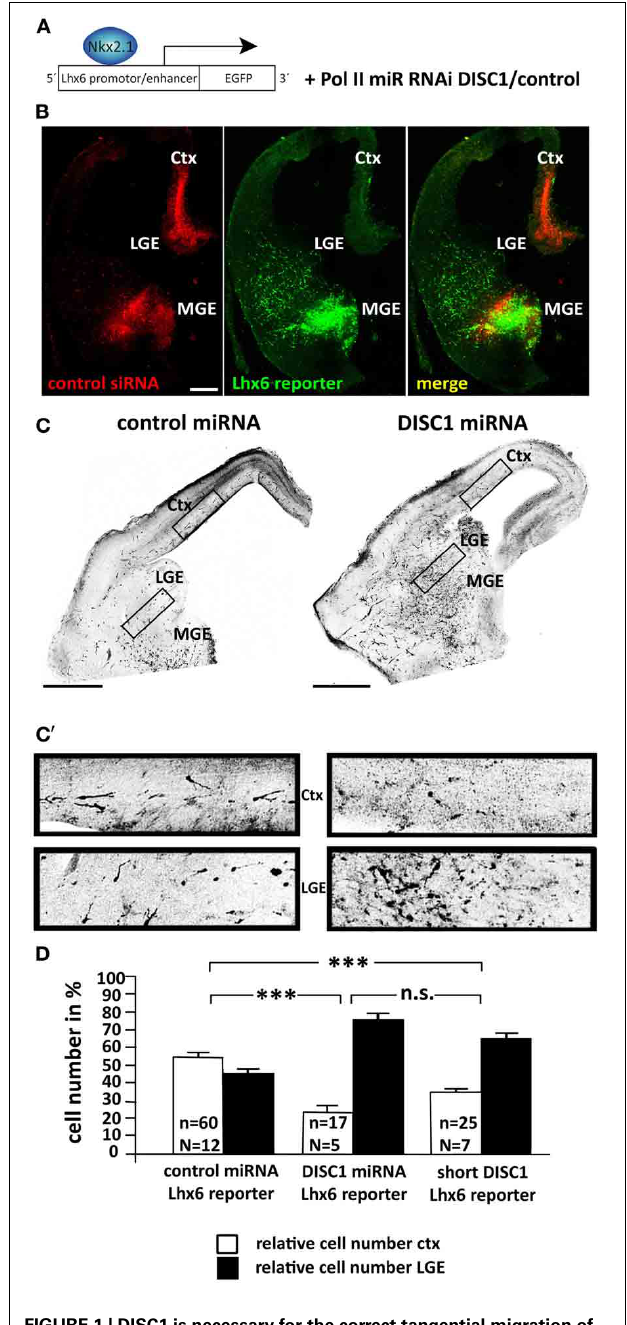
FIGURE 1 | DISC1 is necessary for the correct tangential migration of interneurons in vivo . (A) Schematic of the electroporation strategy. The expression of the reporter construct is controlled by the Lhx6 promotor and labels MGE-derived interneurons. The control and DISC1 miRNA constructs were co-electroporated with the reporter vector in a 4:1 ratio. (B) Photo- micrographs of slice cultures that were ex utero electroporated with the Lhx6 reporter vector that was co-injected with Alexa555 labeled control siRNA in the cortex as well as the MGE. The reporter is only activated in the MGE, but not the cortex. Scale bar: 200 μ m. (C) Inverted fluorescent micrographs of brain slices after in utero electroporation with control or DISC1 miRNA constructs as well as the Lhx6 reporter vector. Scale bars: 500 μ m. (C (cid:2) ) Higher magnified parts of cortex and LGE demonstrate